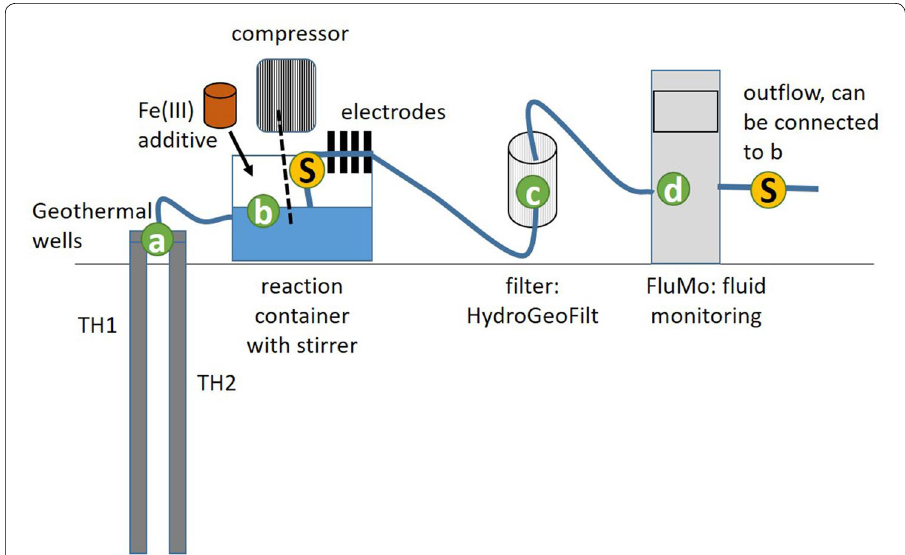
Fig. 1 Experimental set-up: The fluid flows from the two wells (TH 1 and 2; a ) first into the reaction container ( b ), where the Fe(III) additive can be injected and an air compressor is connected to. At the reaction container, also a flow-through cell with electrodes to measure pH, redox, dissolved oxygen (DO) and electric conductivity is installed. After passing through the filter ( c ), the same physicochemical parameters were measured in a monitoring device (FluMo; d ). Sampling was possible at